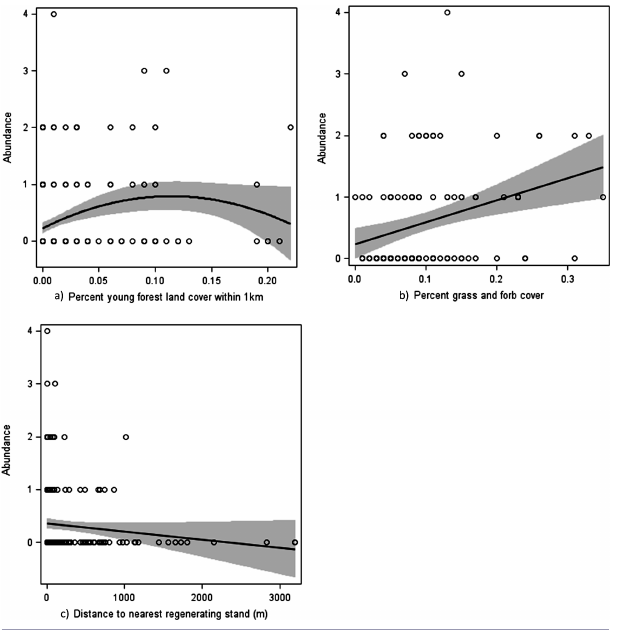
Fig. 2 . Relationship between apparent abundance index (no. of males/survey ± 95% confidence intervals) of Golden-winged Warblers ( Vermivora chrysoptera ) in regenerating stands at the mid-Appalachian scale for (a) percent young forest cover within 1 km and (b) within-stand herbaceous cover and at the northeast regional scale for (c) distance to the nearest timber harvest (m),